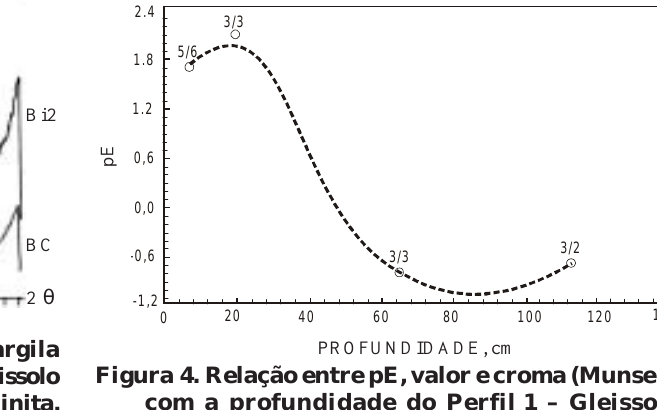
Figura 4. Relação entre pE, valor e croma (Munsell) com a profundidade do Perfil 1 – Gleissolo Háplico Tb distrófico